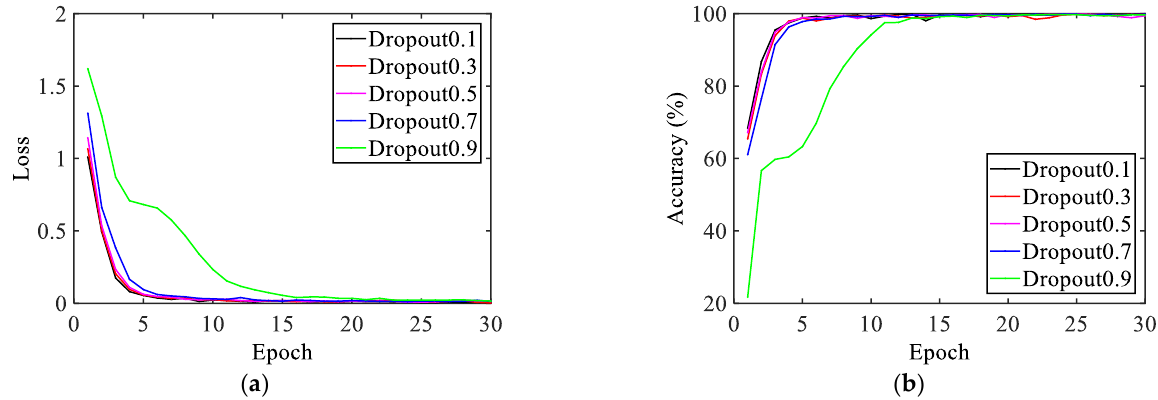
Figure 15. Trend of loss and accuracy. ( a ) Loss , ( b ) accuracy .